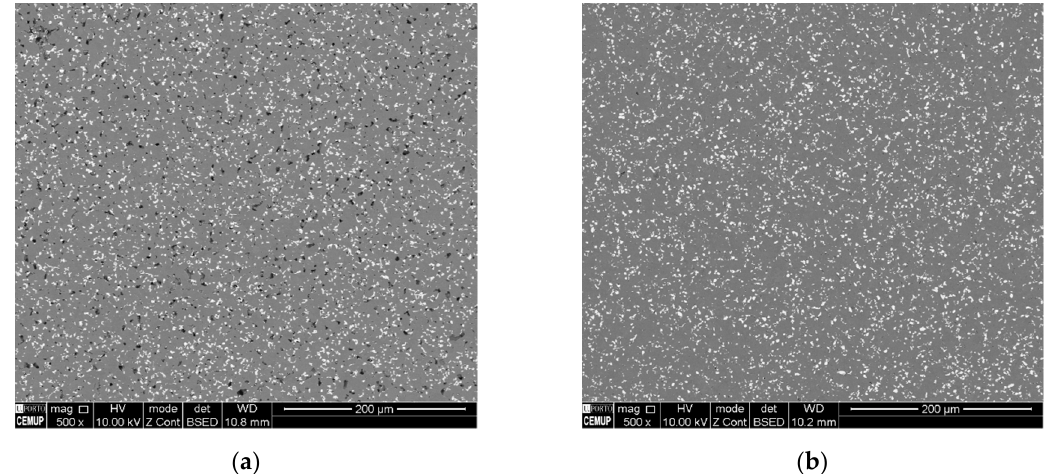
Figure 3. SEM/BSE images of Al-1 WC vol.% composites cold compacted at 76 MPa and sintered at 640 °C in high vacuum (~5 × 10 − 4 Pa): ( a ) Pores (black spots) dispersed in the microstructure of the specimen sintered for 1 h, ( b ) pore-free microstructure of the specimen sintered for 2 h.